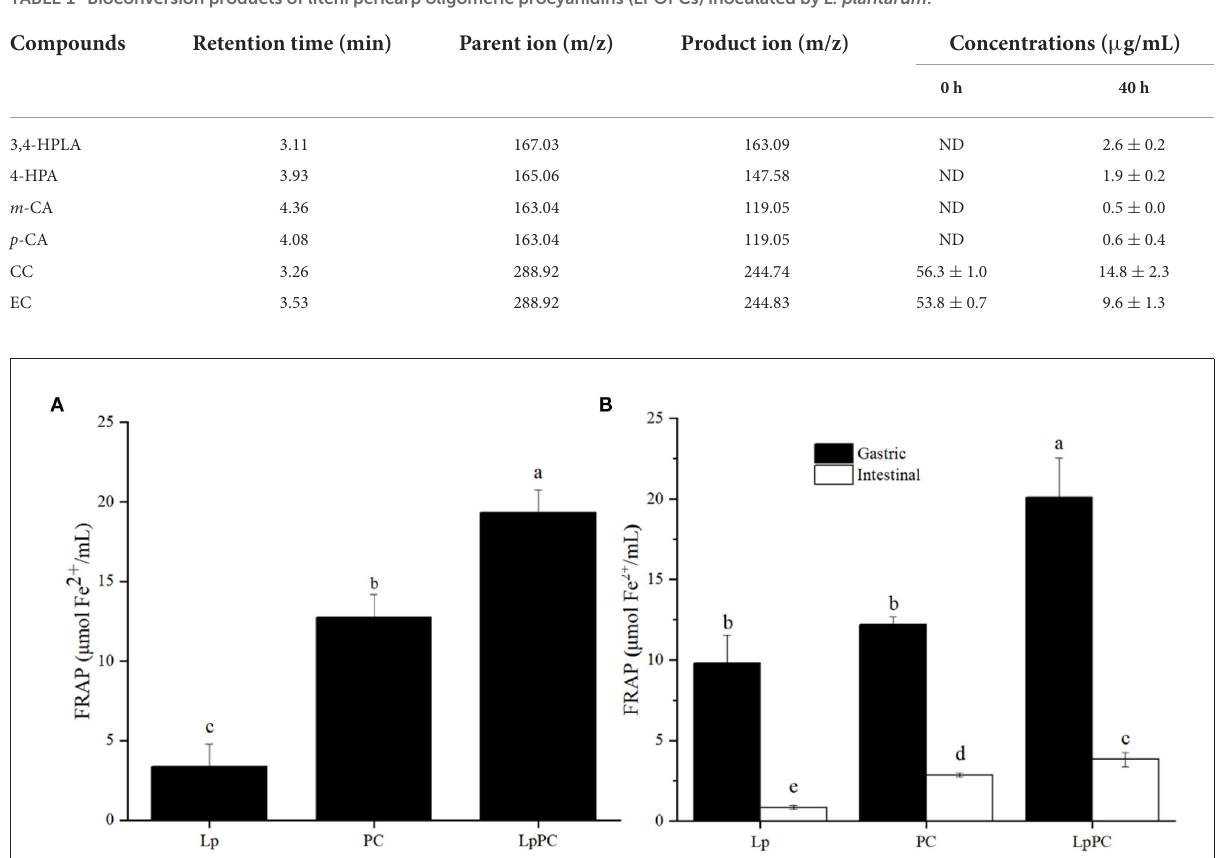
TABLE 1 Bioconversion products of litchi pericarp oligomeric procyanidins (LPOPCs) inoculated by L. plantarum .